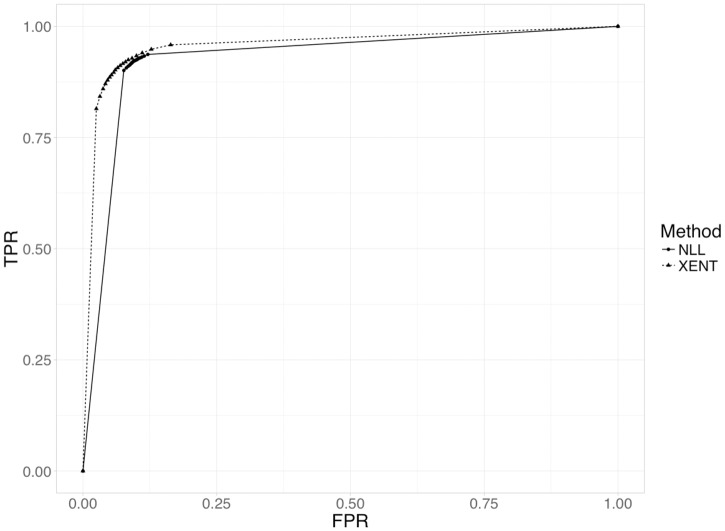
Average ROC curves for cross validation of miRAW’s neural network using the positive and negative training datasets.The dashed line corresponds to the aggregated ROC obtained with the XENT loss function (AUC = 0.96), the solid line corresponds to the NLL loss function (AUC = 0.93). The XENT loss function presents a smoother ROC curve with a higher area under the curve, indicating better performance.